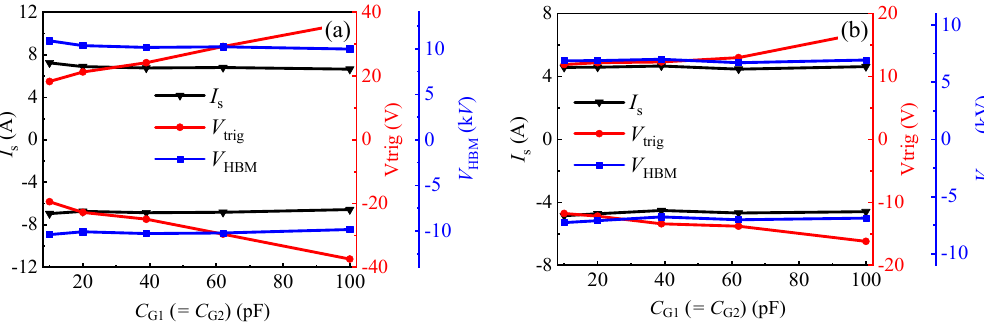
Figure 12. I S , V trig and V HBM of diode 2 ( a ) and diode 3 ( b ) with different C G1 and C G2 values.